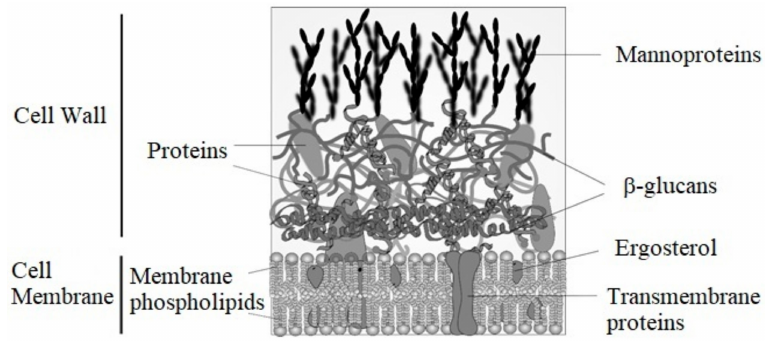
Figure 2. Membrane and cell wall from S.